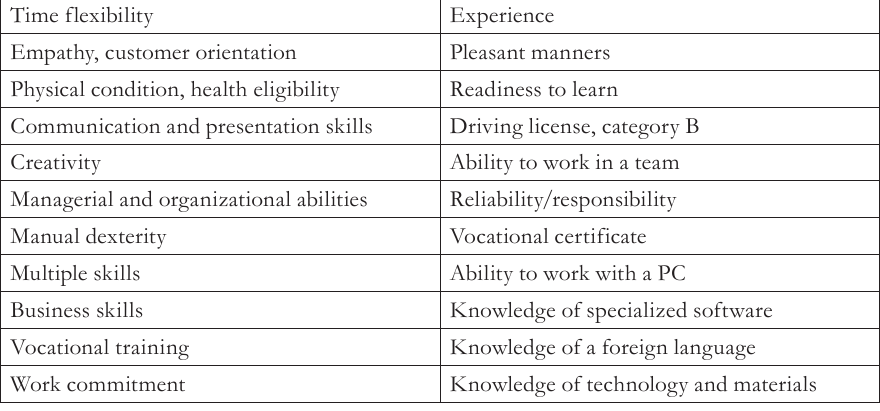
Tab. 4 - Most common general requirements of employers. Source: own